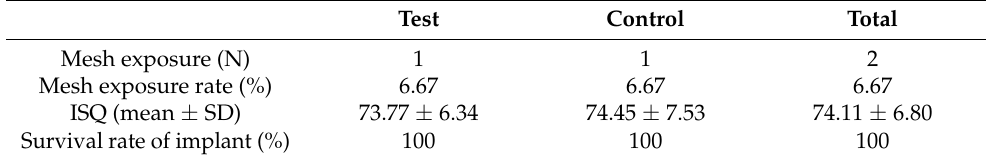
Figure 4. Flowchart for clinical trial enrollment. 3D-PFTM, three-dimensional preformed titanium mesh; CCM, cross-linked collagen membrane; NCCM, non-cross-linked collagen membrane. Table 1. Characteristics of subjects. Table 2. Clinical evaluation of the mesh exposure, ISQ value, and survival rate of implants in both